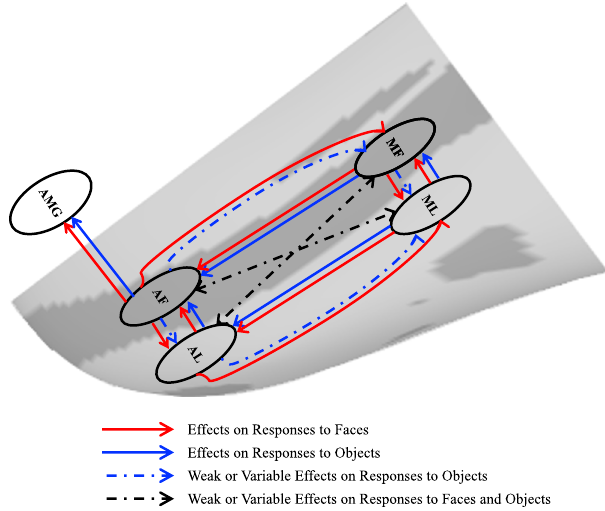
Fig.10|Summaryoftheinternalconnectionsofthefacepatches. Thedirection of thearrows indicates the direction of effects of inactivation. Red lines, effects on responses to faces; Blue lines, effects on responses to objects; Blue dashed lines, weak or variable effects on responses to objects; Black dashed lines, weak or variable effects on responses to both faces and objects. MF middle fundal face patch, ML middle lateral face patch, AF anterior fundal face patch, AL anterior lateral face patch, AMG